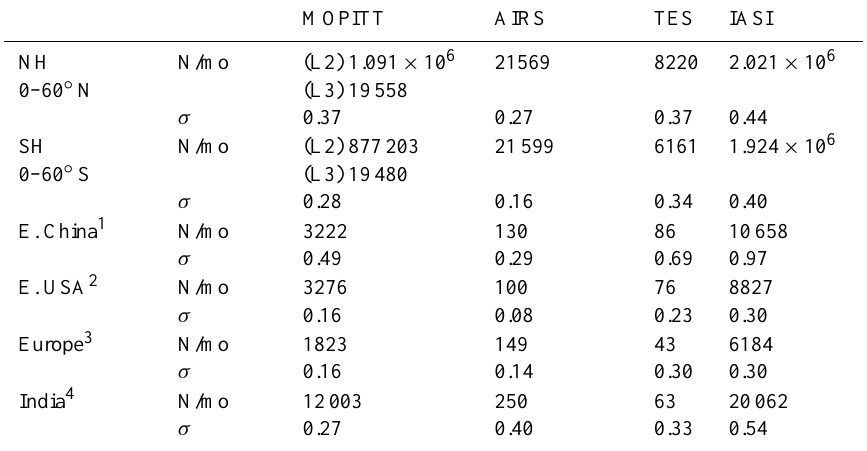
Table 3. Averages for number of observations per month and CO column standard deviation by instrument. N/mo is the average number of observations per month and σ is the CO total column standard deviation (in 10 18 moleculescm − 2 ). For AIRS L3 data, we show a representative month (4/2006), with N/mo as the number of 1 ◦ × 1 ◦ bins in each latitude/longitude range.